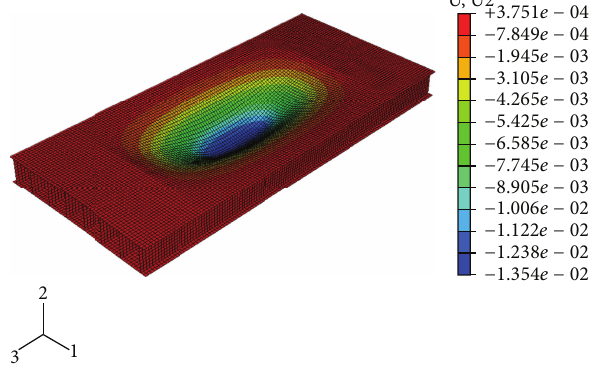
Figure 5: FRP deck displacement